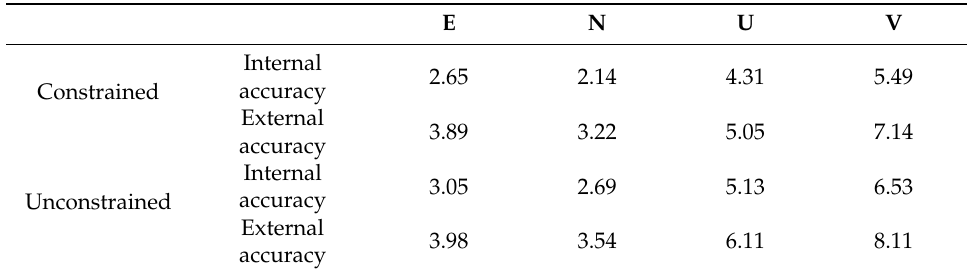
Table 4. Accuracy statistics for tests on the Teaching Experiment building for the E, N and U directions, and the total displacement V (in